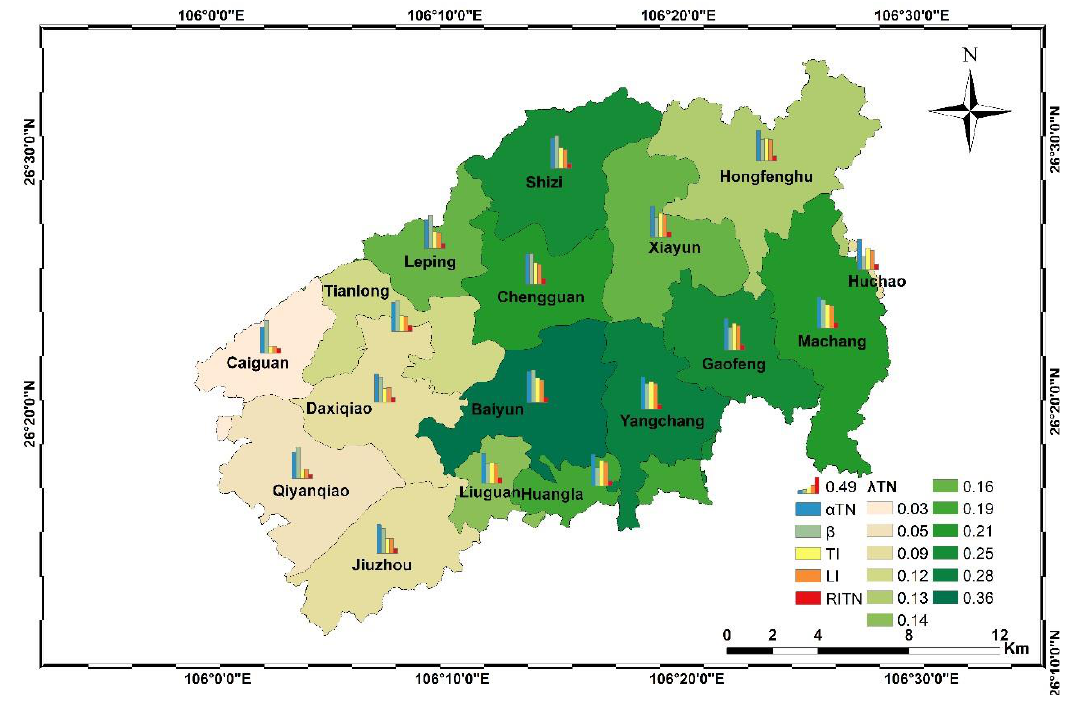
Figure 6. PTRE – NPS of TN at the town scale in the Hongfenghu reservoir watershed.